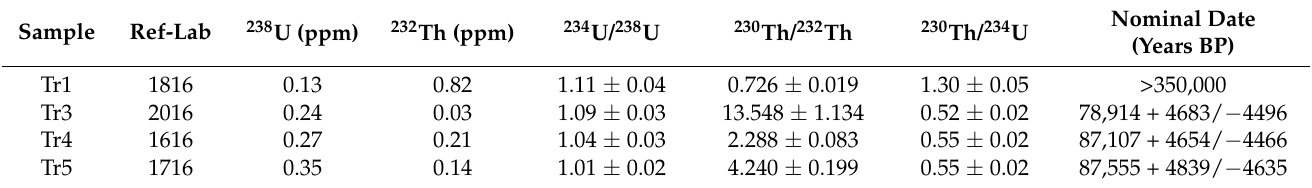
Table 1. U-series radiometric data and derived dates for the Telese and Amorosi travertine samples. Sample